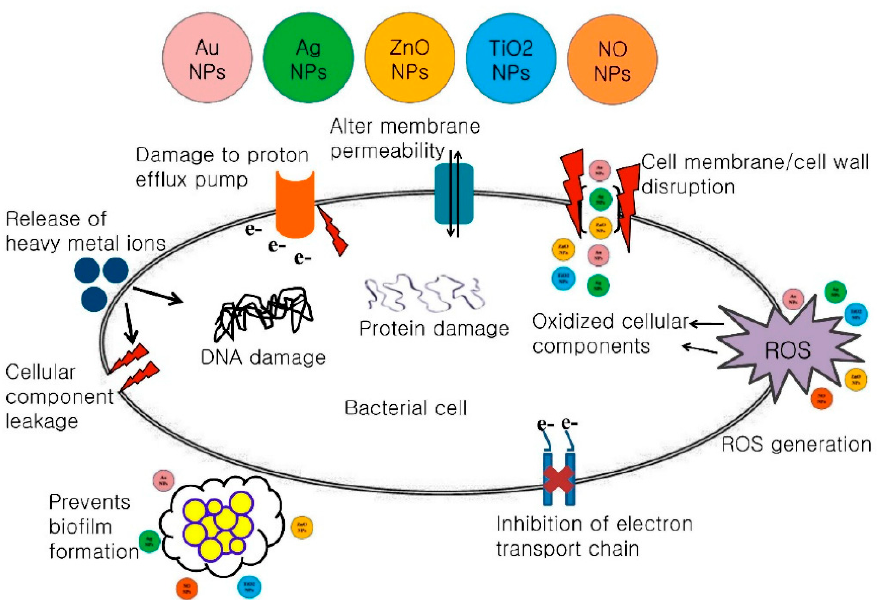
Figure 2. Schematic representations of the antimicrobial mechanisms of various nanoparticles (NPs) [67] .